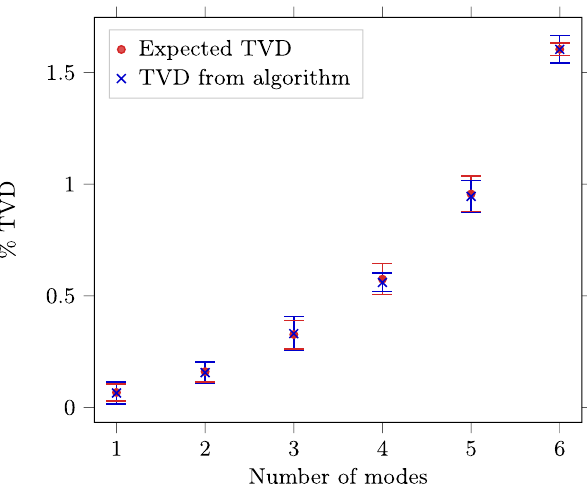
FIG. 2. The total variation distance (TVD) of the proposed algorithm and the expected TVD computed by estimating prob- abilities from brute-force sampling of the ideal distribution. We numerically find the TVD between the exact probabilities and the estimated probabilities for all outputs below the cutoff pho- ton number. The expected TVD is estimated by sampling from the exact distribution. For both sampling algorithms, the proba- bility distribution is estimated by taking a sample of size 200 000 and averaging over ten Haar-random unitaries. The squeezing parameter is 0.5 in all modes, giving an average photon num- ber of approximately 0.27 per mode, and we choose a cutoff of six photons. The error bars show the standard deviation of the ten repeated